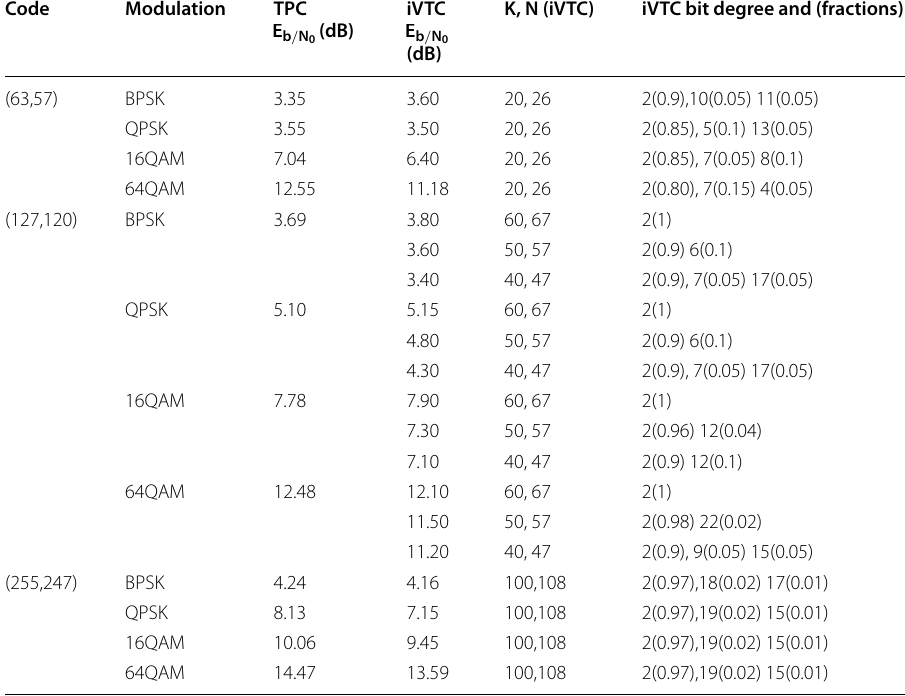
Table 2 Comparison between the required E b / N 0 for TPC and iVTC to achieve a low BER ( 10 − 5 ) in an AWGN channel